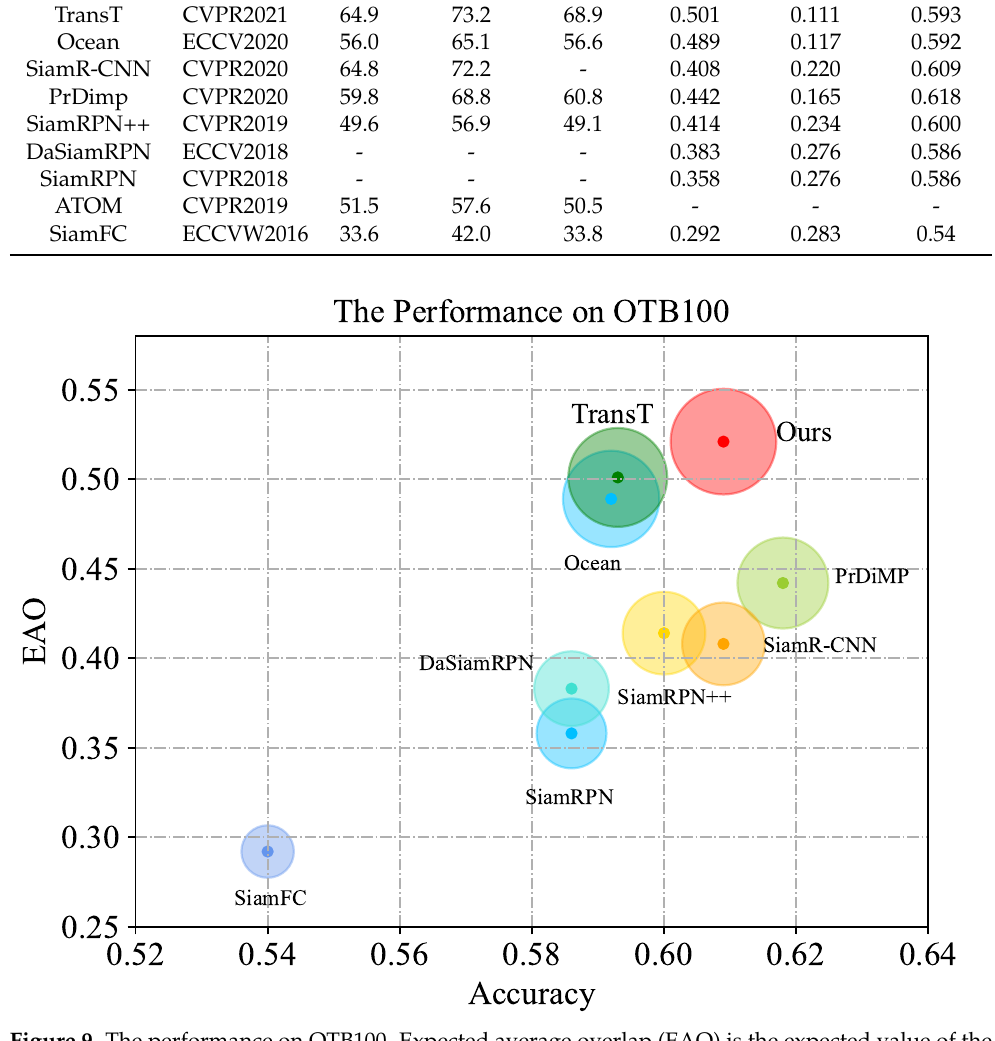
Figure 9. The performance on OTB100. Expected average overlap (EAO) is the expected value of the non-reset overlap of each tracker on a short-term image